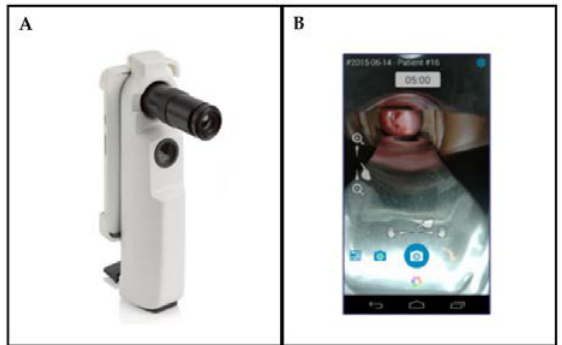
Figure 5. The EVA system ( A ) and an application image utilized to visualize the uterine cervix ( B ) (Reprinted with permission from Ref. [60]. Copyright 2016 Society of Photo-Optical Instrumentation Engineers